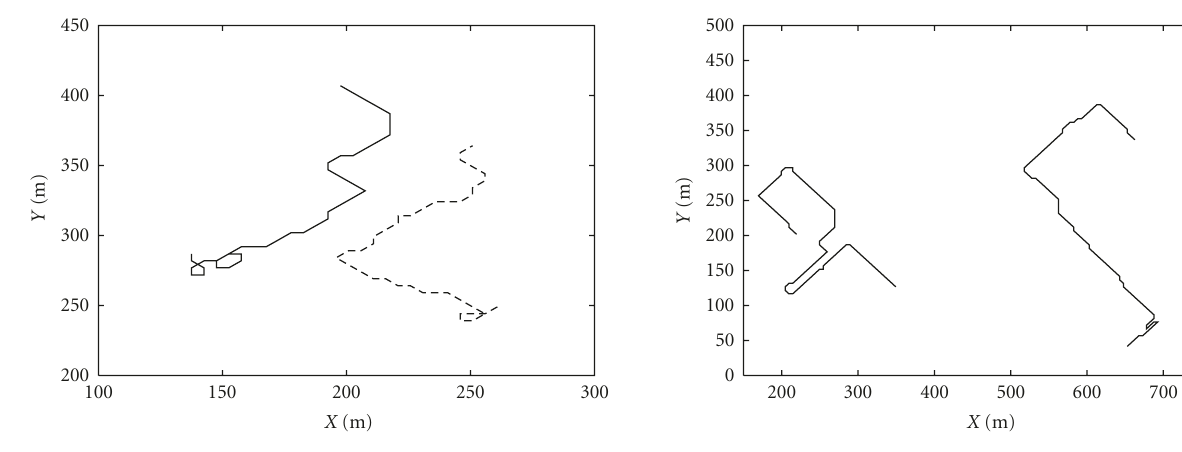
Figure 5: Course of two MNs using the SIMMa profile. Figure 6: Course of the MN following the SIMMb profile.